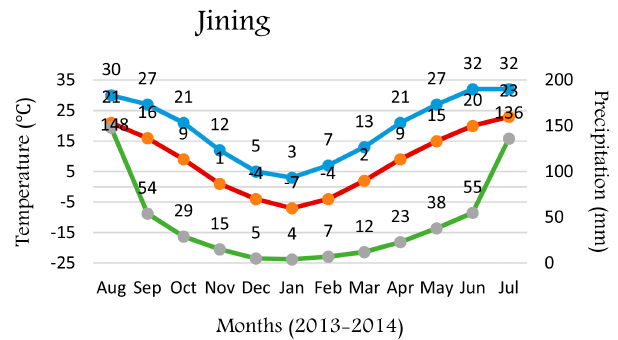
Figure 1. Precipitation and temperature of experiment stations. Cultivars were sown in October 2013 and harvested in June 2014 in both stations.